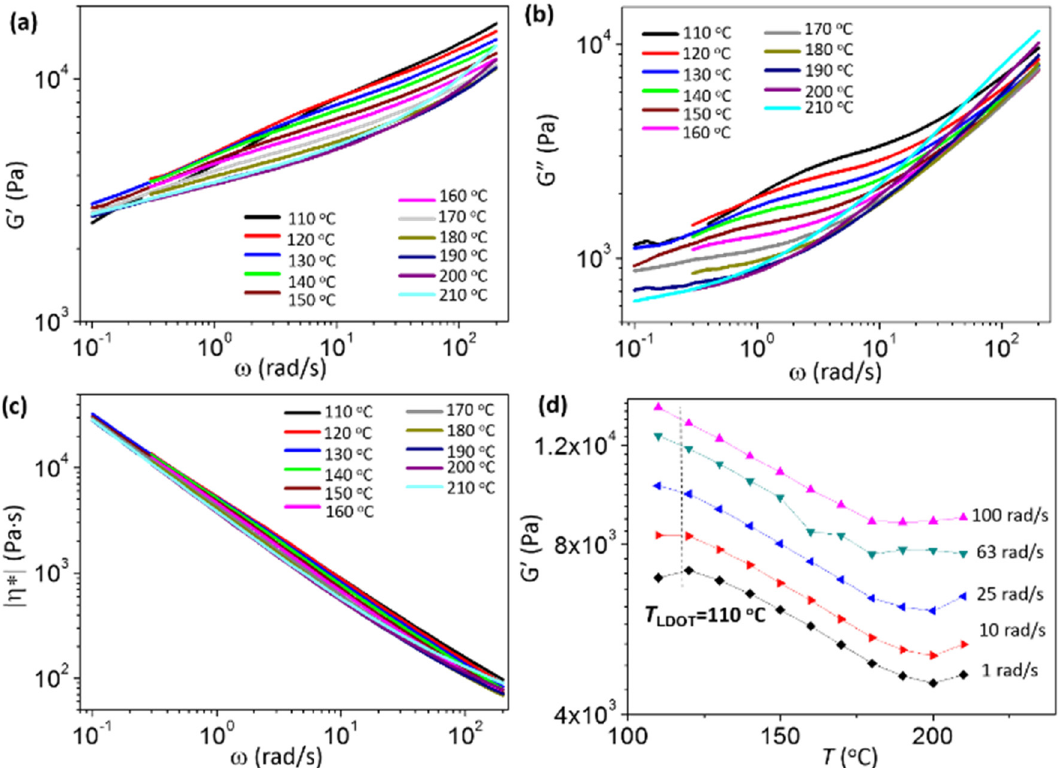
Figure 5: ( a ) Storage modulus ( G ′ ) , ( b ) loss modulus ( G ″ ) , and ( c ) complex viscosity (| η * |) versus angular frequency ( ω ) from dynamic oscillation at a fi xed temperature range from 100°C to 210°C with the interval of temperature at 10°C for ( S 15.4 - 0.21 - B 46.6 ) 3 , and ( d ) isochronal plots of G ′ versus temperature ( T ) for ( S 15.4 - 0.21 - B 46.6 ) 3